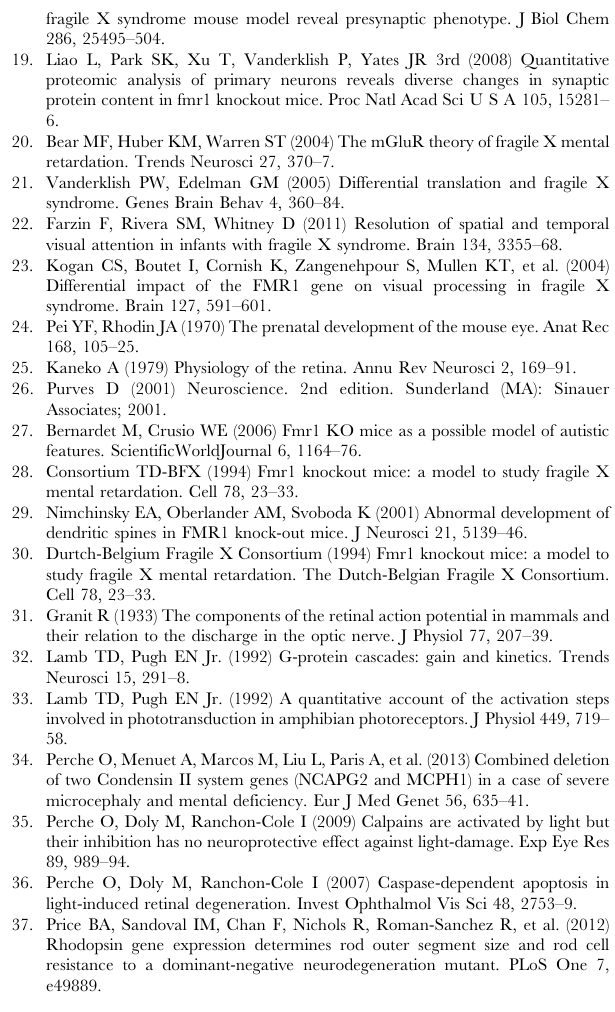
Supporting Information S1 Figure 1S: Representative ERGs obtained from WT or Fmr1 KO mice. Figure 2S: Retinal layers thicknesses in WT and Fmr1 KO retinas. Figure 3S: Synaptic markers mRNA expression in WT and Fmr1 KO